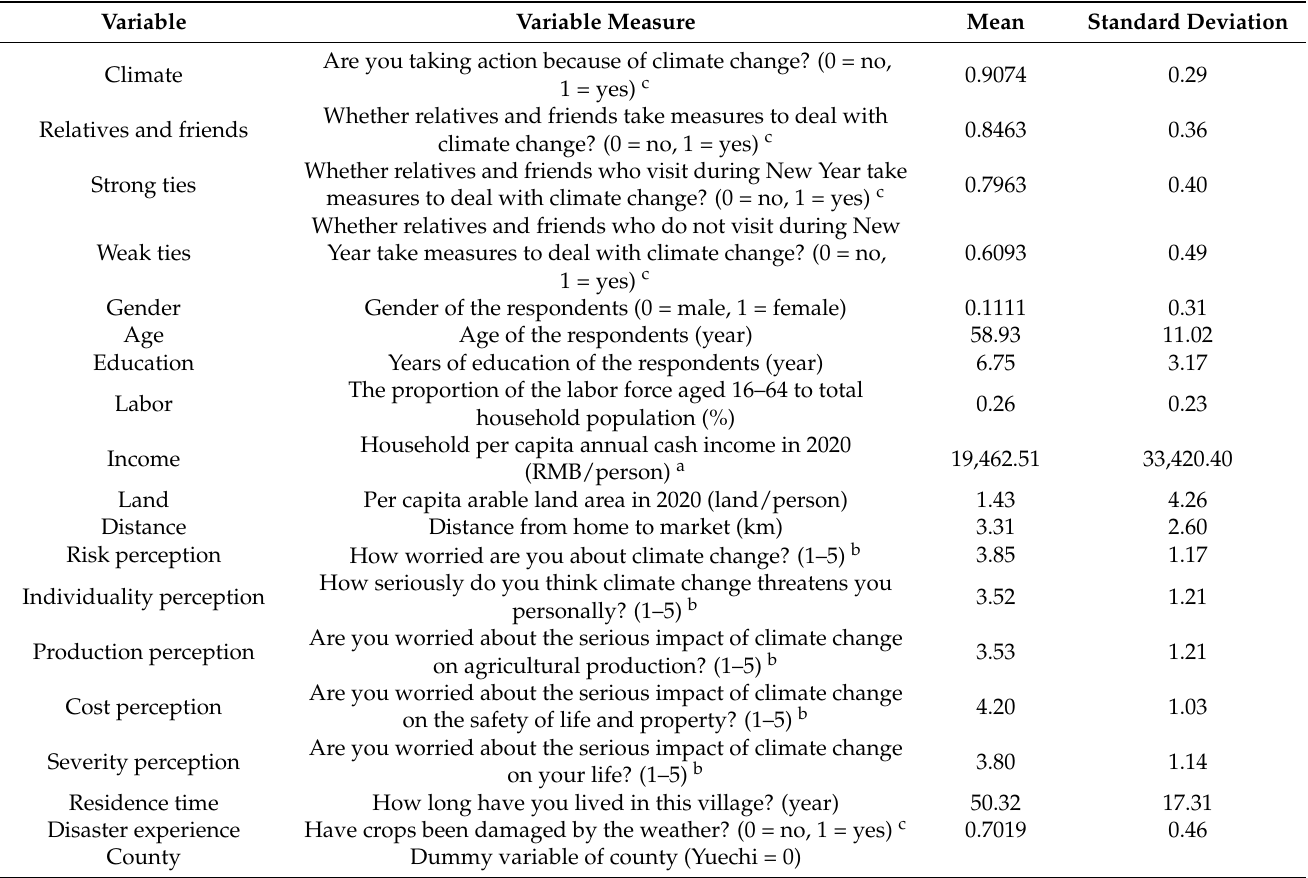
Table 2. Variable definitions and descriptive